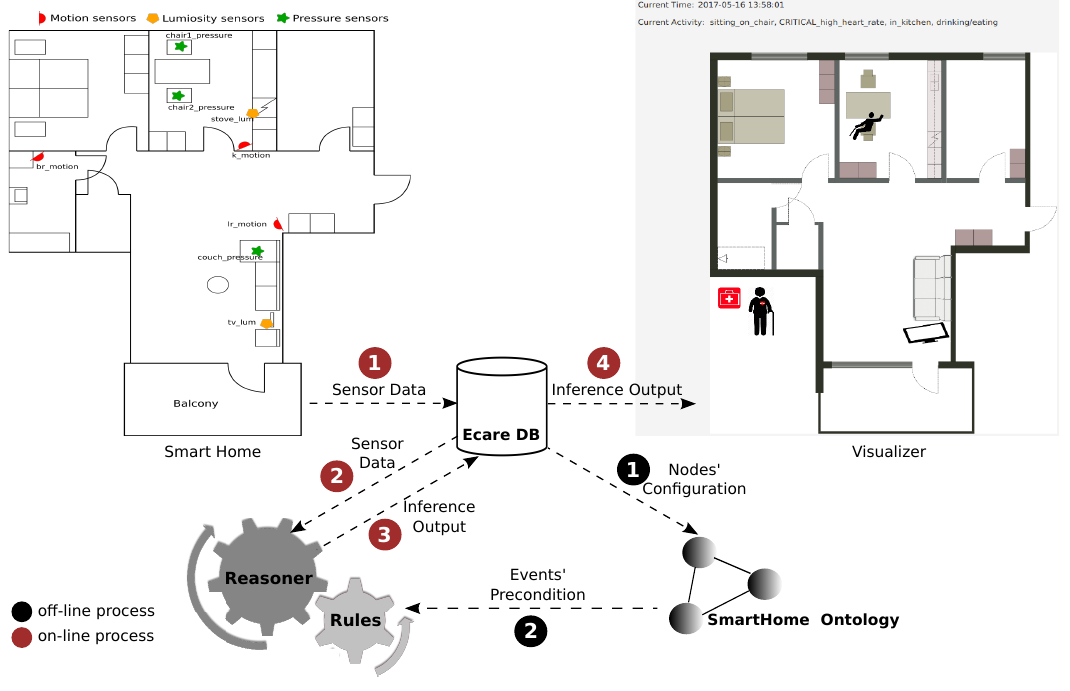
Figure 1. An abstract view of the context recognition system in E-care@home: The system is initialized offline based on the black-labeled links. After the initialization, the running system relies on communication links among different modules shown in red